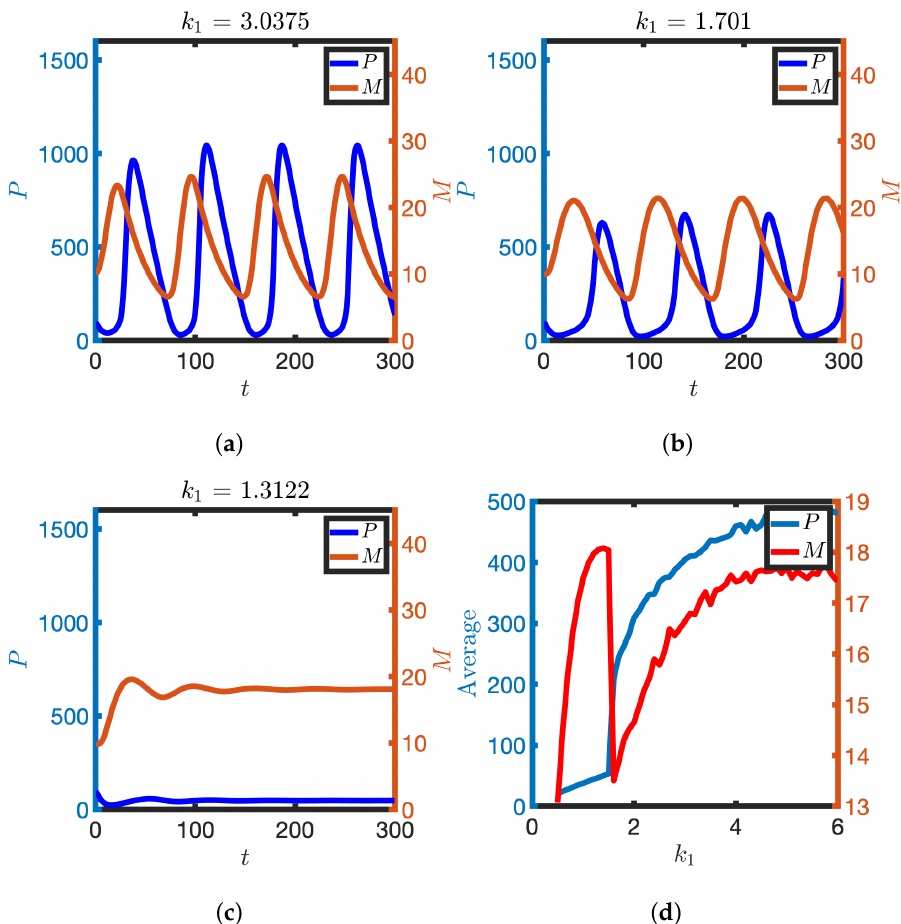
Figure 8. The effect of partial reduction of the transcription rate, k 1 . ( a – c ) M and P are plotted against time for different transcription rates. ( d ) The detectable amount of M and P is plotted against k 1 (see Equation (4)). Equation (2) were solved numerically. Other parameter values as in Table